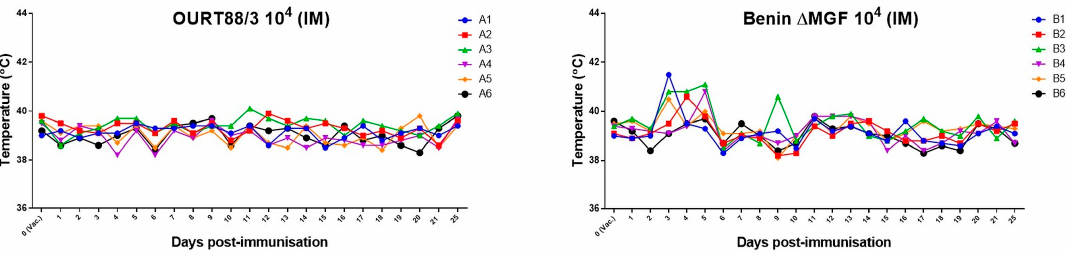
Figure 1. Rectal temperatures in pigs. Rectal temperatures were assessed at different days after immunization with two different African swine fever virus (ASFV) strains, ( a ) OURT-88/3 and ( b ) deletion mutant BeninDMFG, by an intramuscular route. Before inoculation, rectal temperatures of pigs ranged between 39 and 39.9 °C. At day 24 post immunization, the rectal temperatures of pigs immunized with OURT88/3 ranged between 39.4 and 39.9 °C, while in the group of pigs immunized with Benin Δ MGF, temperatures ranged between 38.7 and 39.6 °C.